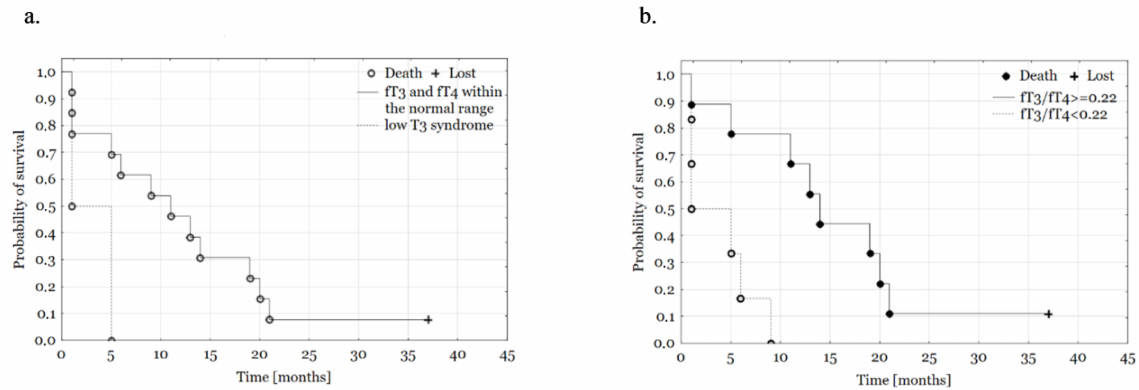
Figure 3. Kaplan-Meier curves in groups according to presence of low T3 syndrome ( a ) and fT3/fT4 status ( b